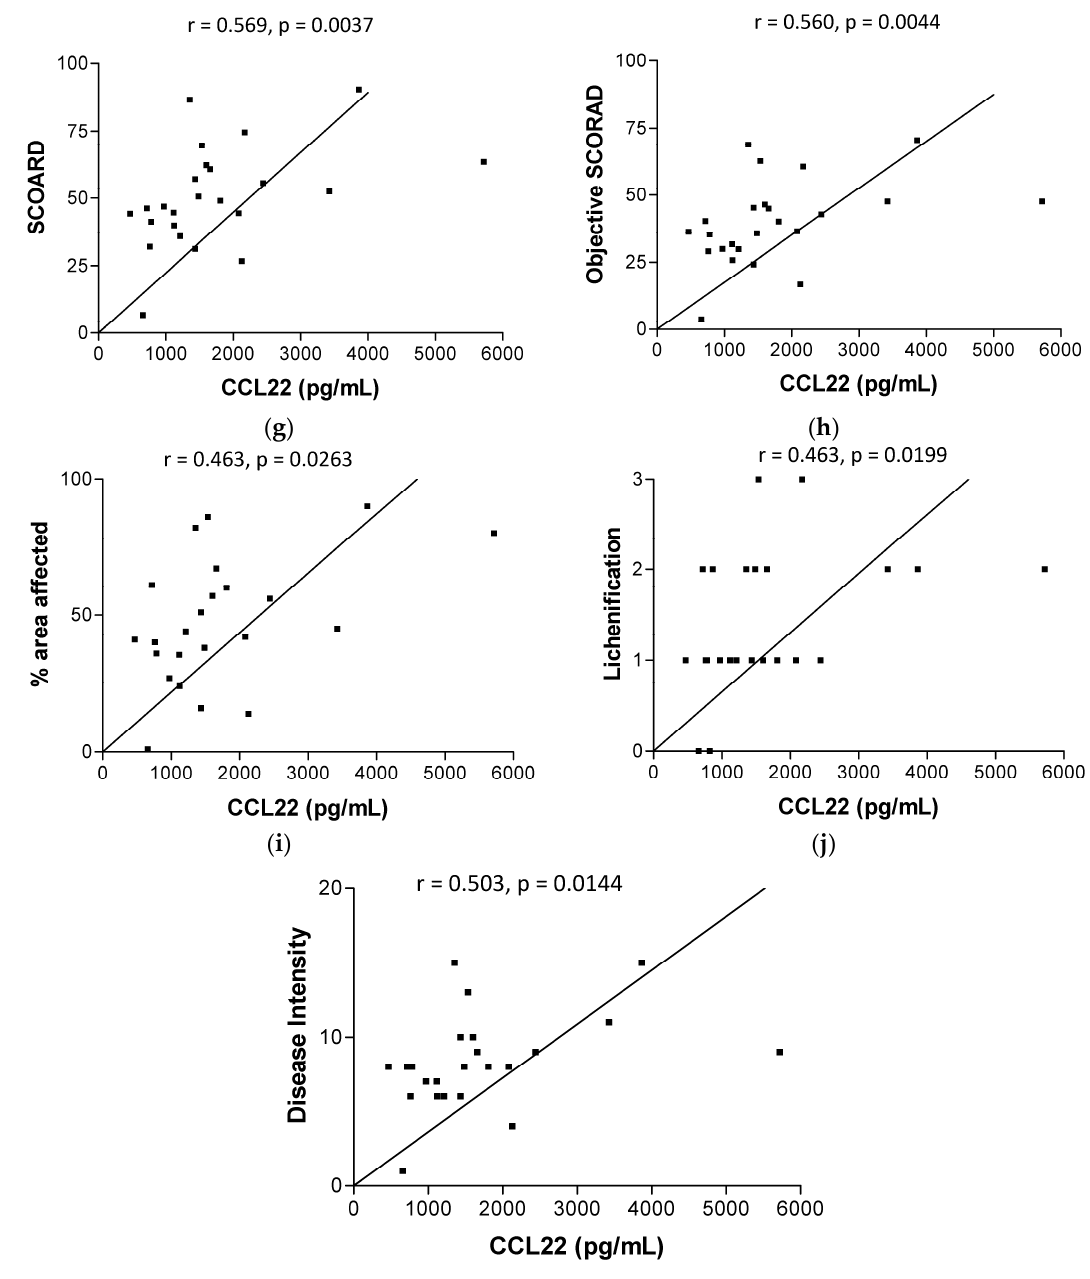
Figure 2. Correlations between plasma concentrations of CCL27 and CCL22 with SCORAD, objective SCORAD, % area affected, lichenification, disease intensity and pruritus in AD patients. Correlation and significant were determined by non-parametric Spearman’s correlation test.